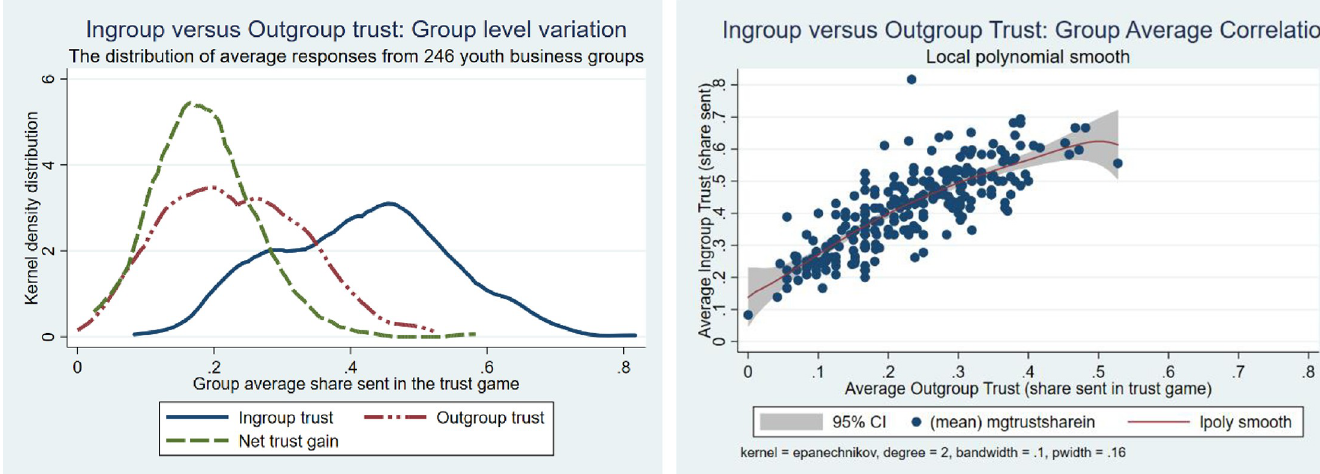
Fig 4. a. Average ingroup and outgroup trust and net trust gain. b. Average ingroup and outgroup trust correlation.